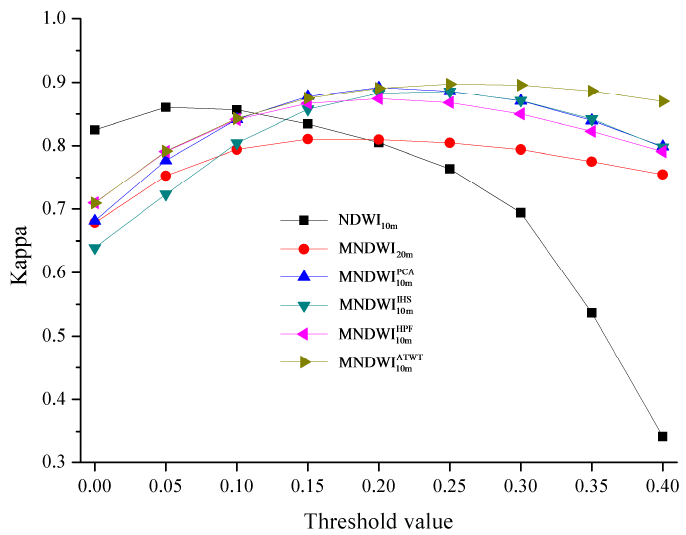
Figure 7. The mean Kappa values of the water maps of Subarea A, B and C produced by different water mapping threshold values (in the range of 0 to 0.4).